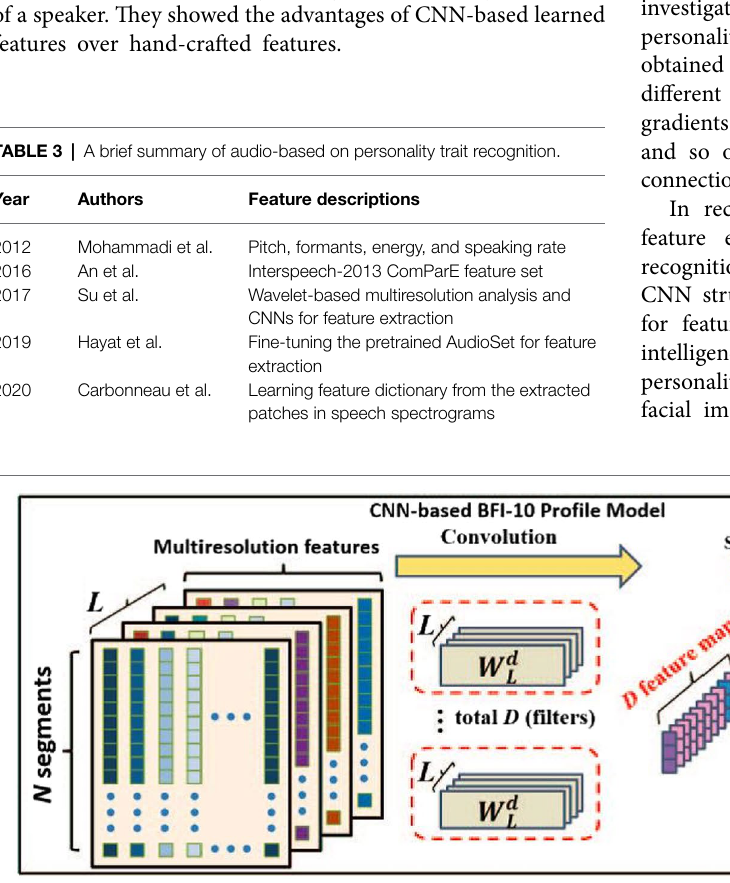
FIGURE 2 | The used CNN scheme for personality trait perception from speech signals (Su et al.,